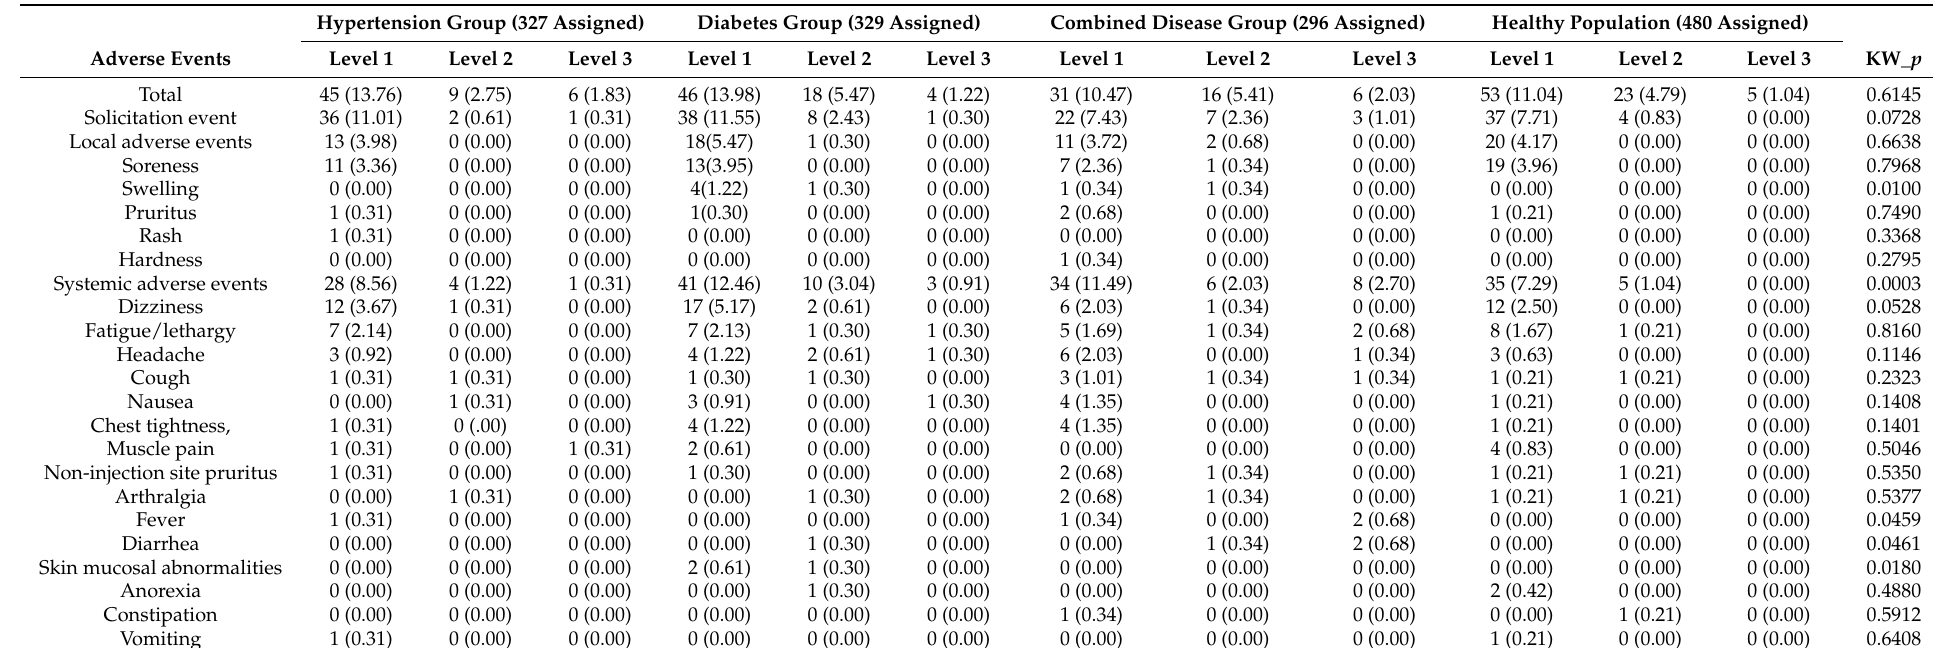
Table 3. Severity of adverse events 0–21 days after two doses of vaccine in the whole